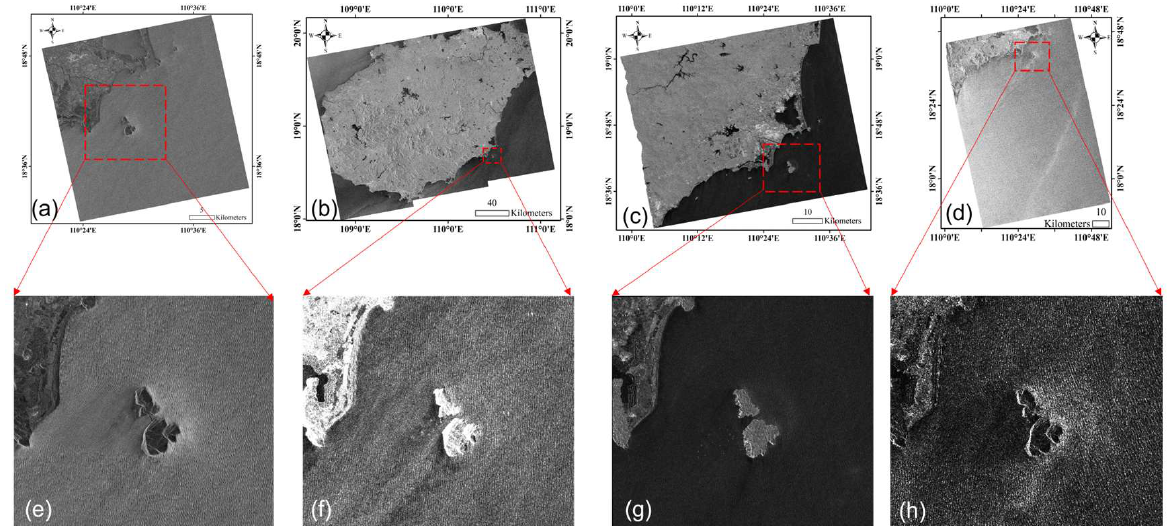
Figure 2. The pre-processed SAR image of the Dazhou Island: ( a ) GF-3 HH-polarized; ( b ) Sentinel- 1 VV-polarized; ( c ) ALOS PALSAR HH-polarized; ( d ) ENVISAT ASAR HH-polarized. The corresponding clipped images were shown as ( e – h ).